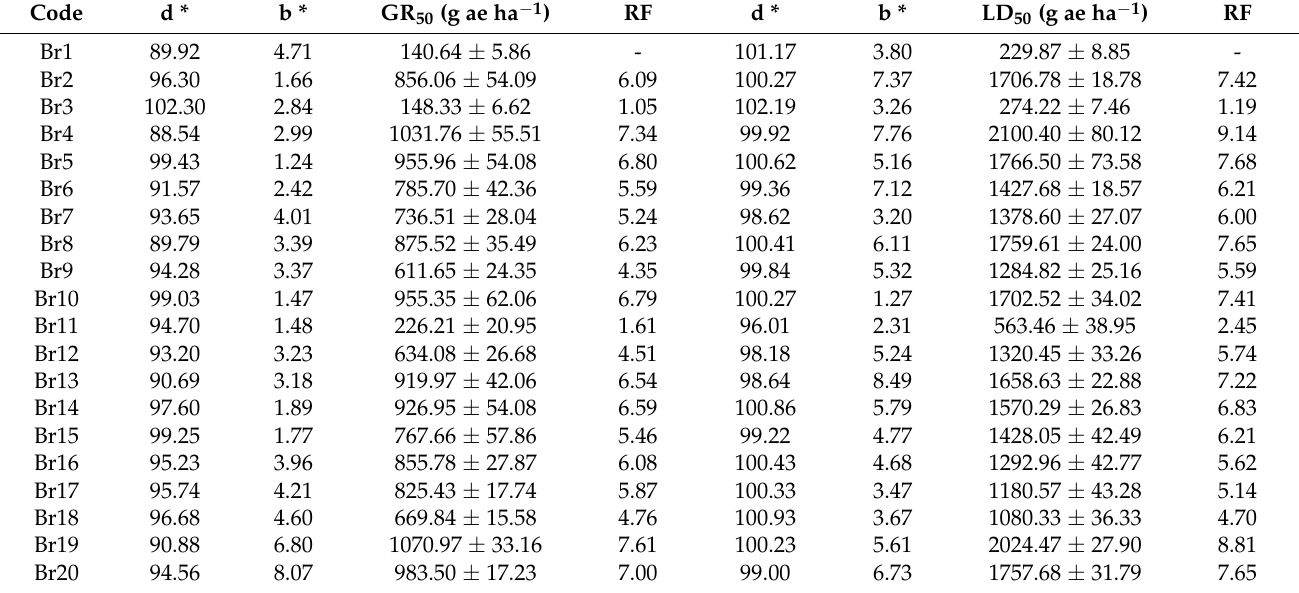
* d is the upper coefficient and b is the slope of the curve.